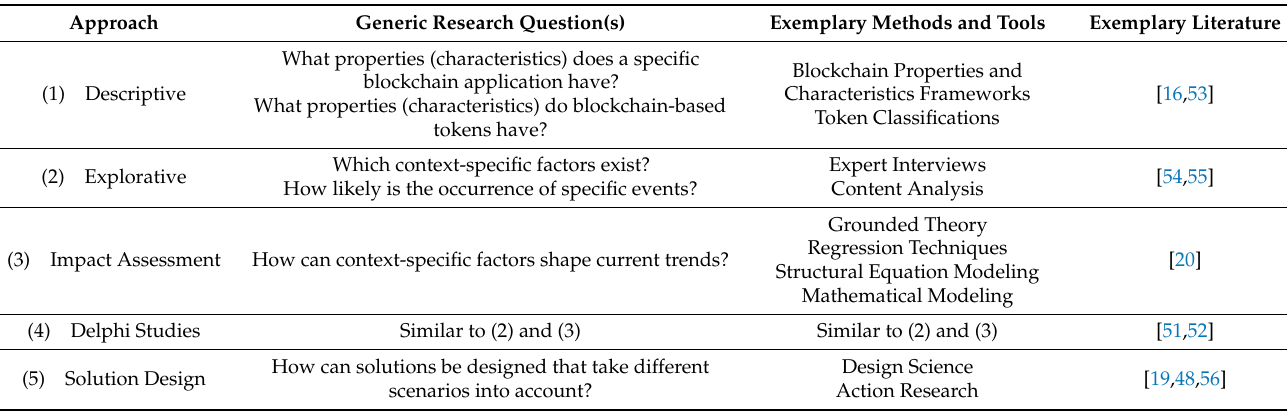
Figure 3. A framework for scenario-based blockchain research. Table 2. Scenario-based approaches for blockchain